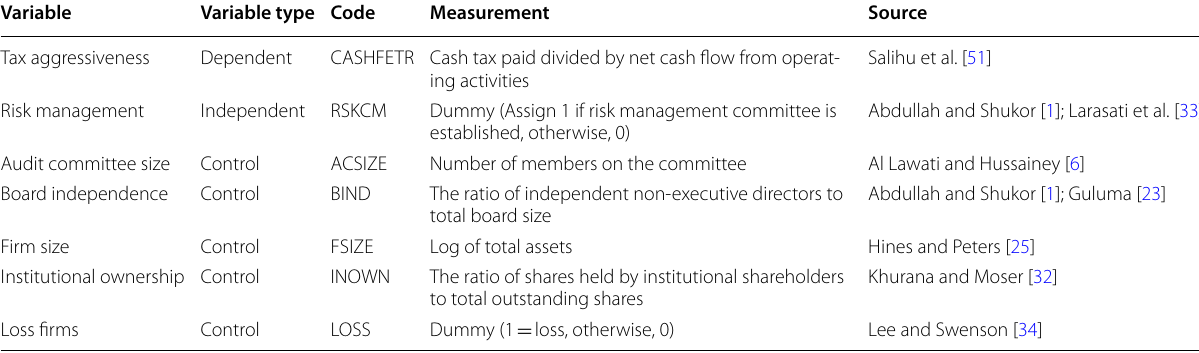
Table 2 Variable measurement. Source : Researcher’s compilation (2022)